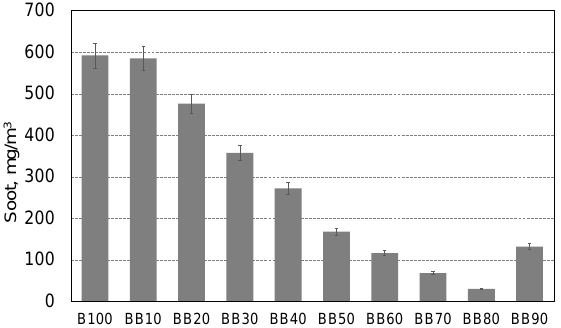
Figure 12. Soot emission.